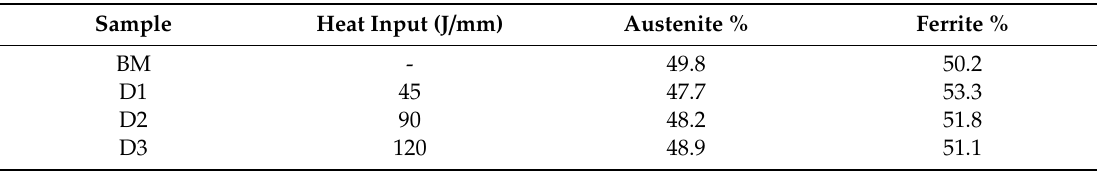
Table 3. Phase proportions in the fusion zone.